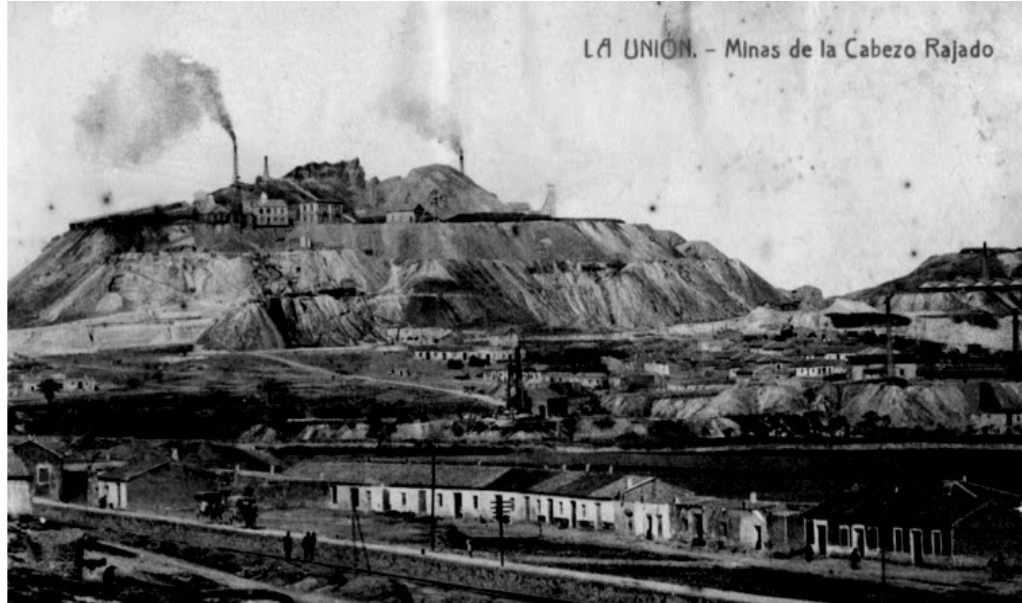
Figure 1: View of Cabezo Rajao in 1910 (source: Rogelio Mouzo Pagán.